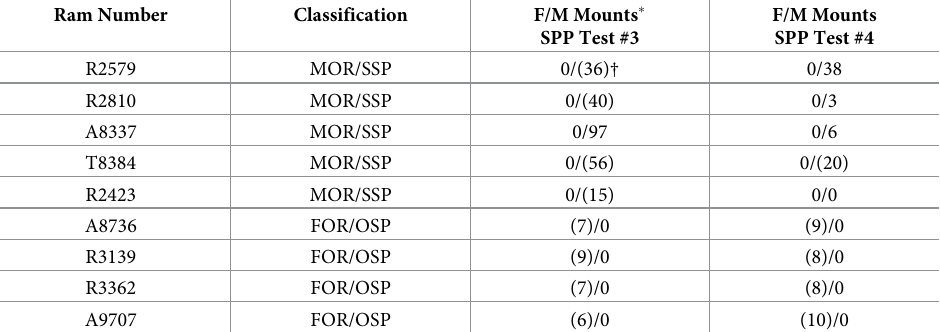
Table 1. Number of mounts on female and male stimulus animals in the last two of four sexual partner preference